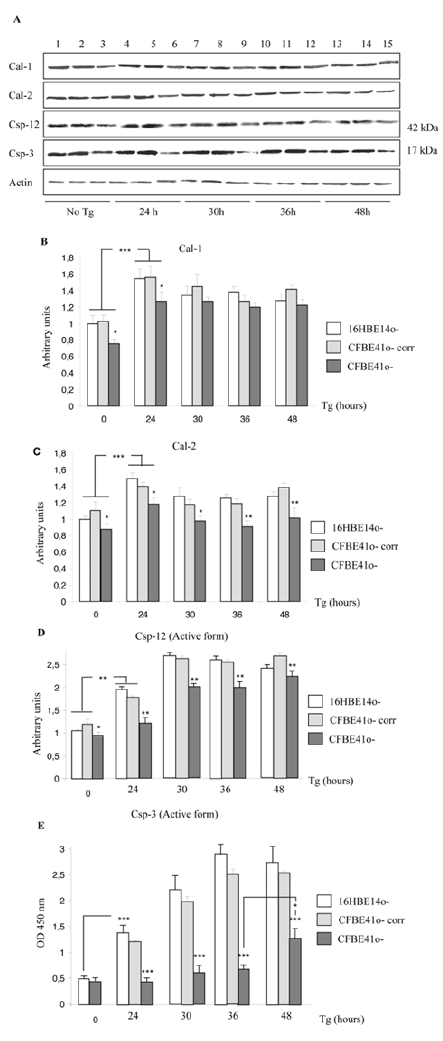
Figure 3. Expression of Cal-1, Cal-2, active Csp-12 and active Csp-3 in 16HBE14o-, CFBE41o- corr and CFBE41o- cells in the presence of Tg. A. Example of western blots showing the expression of Cal-1, active Csp-12, active Csp-3 and actin in 16HBE14o- (1, 4, 7, 10, 13), in CFBE41o- corr cells (2, 5, 8, 11, 14) and CFBE41o- cells (3, 6, 9, 12, 15) at different time point of Tg treatment. B. Histogram represents the quantification of Cal-1 in 16HBE14o-, CFBE41o- corr and CFBE41o- cells in the absence (0 time point) and after 24, 30, 36 and 48 hours induction by Tg. In all cell types the Cal-1 is increased in the presence of Tg. The increased expression of Cal-1 is lower in CFBE41o- cells. At the 30 time point the difference is abolished. Bars represent SEM (n=7). C. Histogram represents the quantification of Cal-2. In all cell types the Cal- 2 is increased in the presence of Tg. The increased expression of Cal-1 is lower in CFBE41o- cells. Bars represent SEM (n=7). D. Result of the statistical analysis of the active Csp-12 expression when Tg was applied on the cells. It indicates that the active Csp-12 is overexpressed in all cell types after Tg treatment. The overexpression is lower in F508del-CFTR expressing cells. Bars represent SEM (n=7). E. The-quantification of the active Csp3 was performed using an ELISA kit as described in the methods. The histogram represents statistical analysis of the optical densities (OD, 450 nm) which are proportional to the quantity of the cleaved-Csp-3 in the cell lysates. It is observed that in 16HBE14o- and CFBE41o- corr cells the cleaved form is increased after 24 hours of Tg treatment whereas it is increased in CFBE41o- cells after 48 hours. Nevertheless, the amount of the cleaved-Csp-3 remains lower in CFBE41o- cells. Bars represent SEM (n=6).